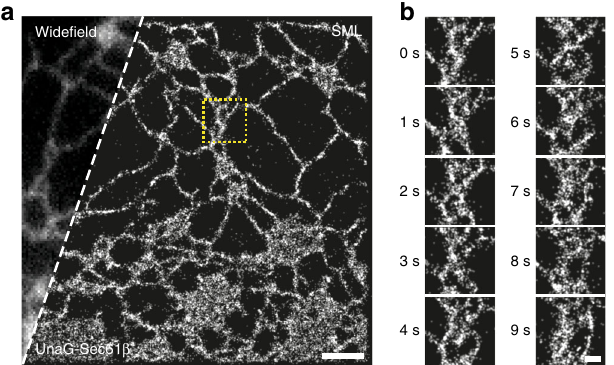
Fig. 5 Live-cell super-resolution microscopy. a , b One-second-long SML images of the ER in a live Cos7 cell transfected with UnaG-Sec61 β . a A far view with conventional wide fi eld and SML images. The wide fi eld image was taken immediately before super-resolution imaging. b A time series of closed-up SML images from the yellow-boxed region in a . Scale bars: 2 µ m for a ; 500 nm for b .